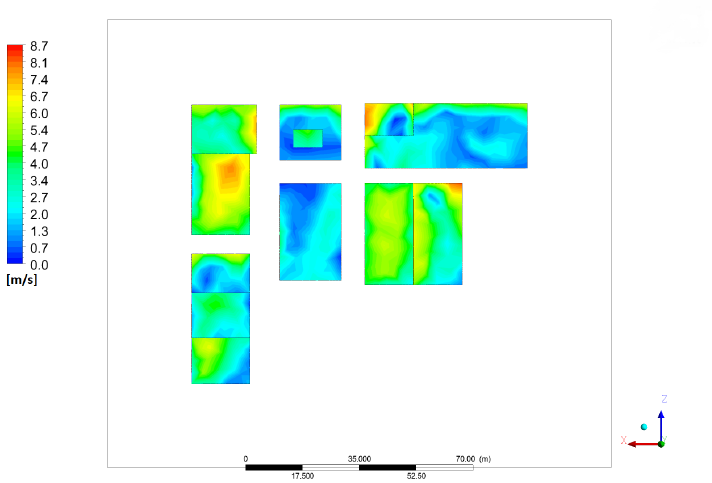
Figure 5. Speed contours in the north–south plane in the flow of air through buildings.